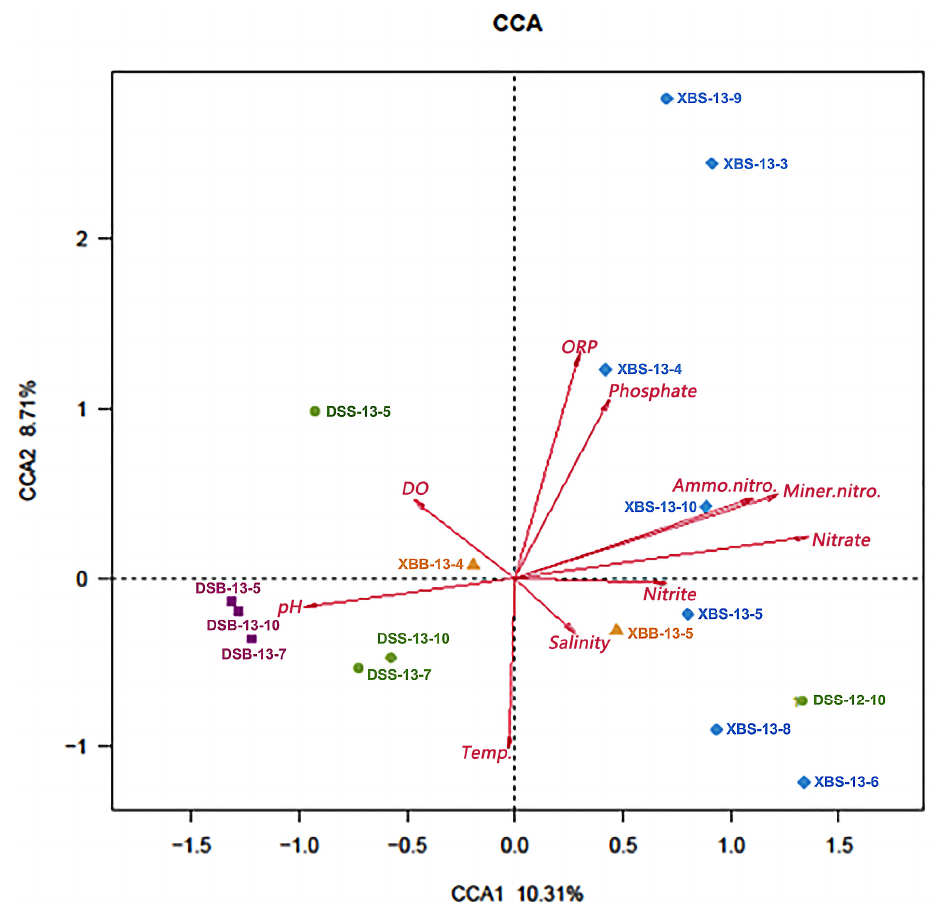
Figure 7. CCA biplot of the distribution of bacterial communities in relation to environmental factors. Numbers in the figure indicate sample names: Subgroup name–year–month; different colors or shapes indicate sample groups in different environments; arrows indicate environmental factors; the angle between samples and environmental factors represents positive and negative correlations between samples and environmental factors (acute angle: Positive correlation; obtuse angle: Negative correlation; right angle: No correlation).